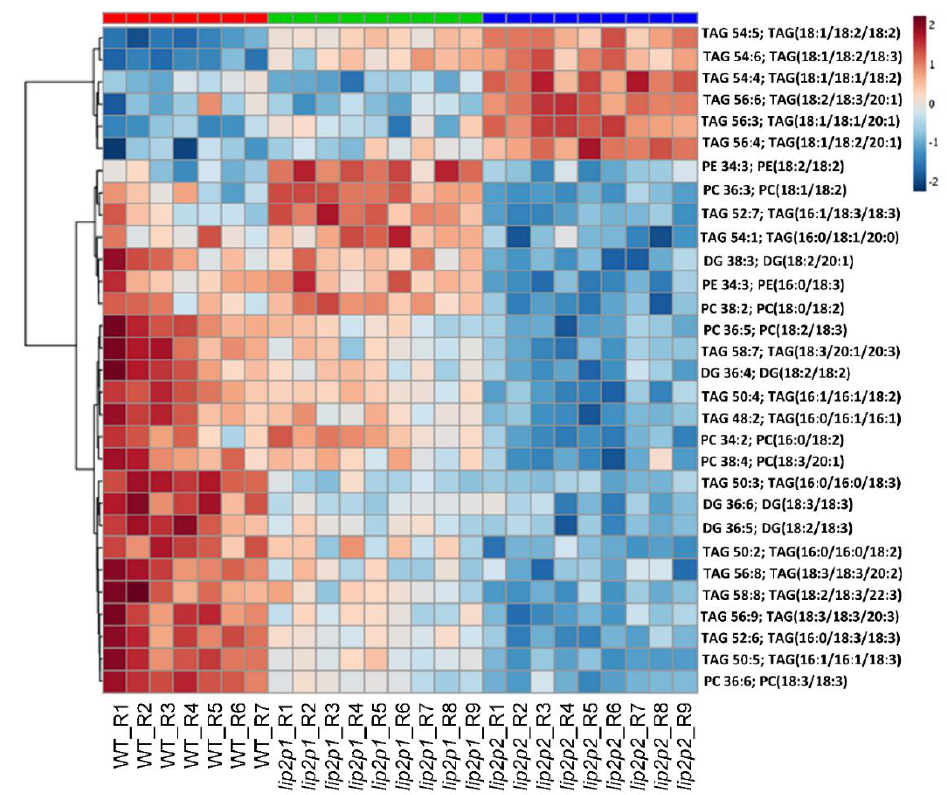
Figure 7. Heatmap of the most statistically different lipids species (right) comparing the control (WT, red) and the octanoyltransferase mutant mature seeds ( lip2p1 , green, and lip2p2 , blue). TOP 25 p < 0.001 ANOVA Tukey non-parametric.